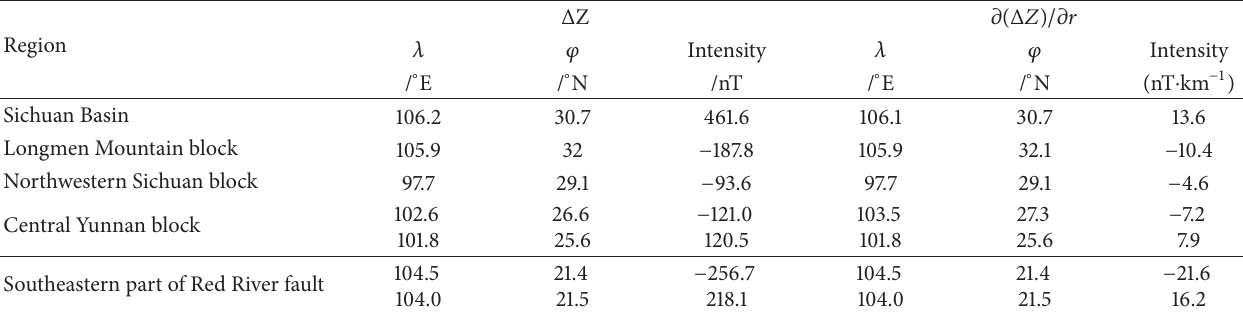
Table 1: The location and intensity of magnetic anomaly foci of Δ𝑍 and 𝜕(Δ𝑍)/𝜕𝑟 for each block at the Earth’s surface.